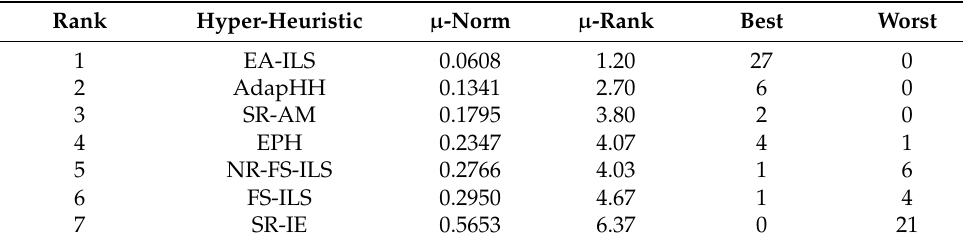
Table 8. Overall Performance on the Extended Hyflex Test